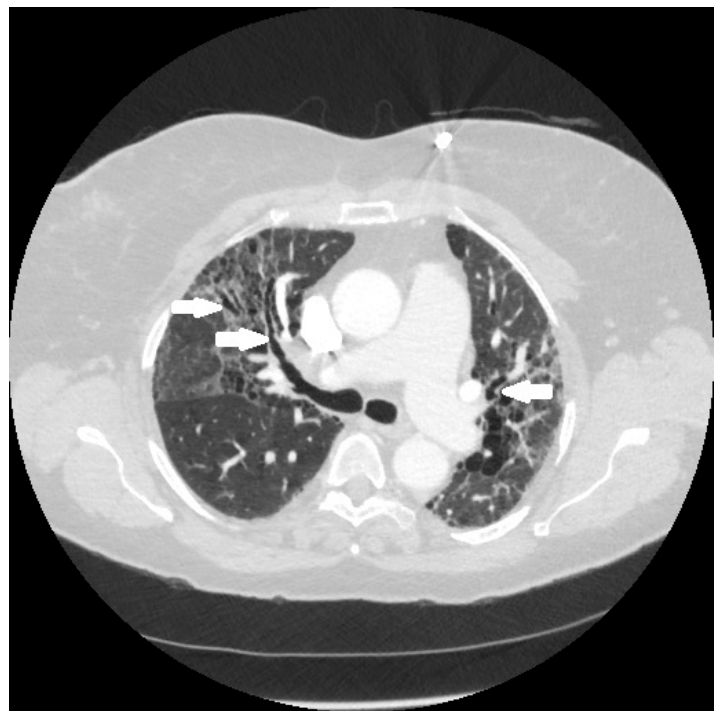
Figure 8. Chest CT scan of fibrotic pulmonary sarcoidosis. The fibrosis is typically in a peribronchial location, which in this case has resulted in fibrosis-induced traction bronchiectasis of airways (arrows).